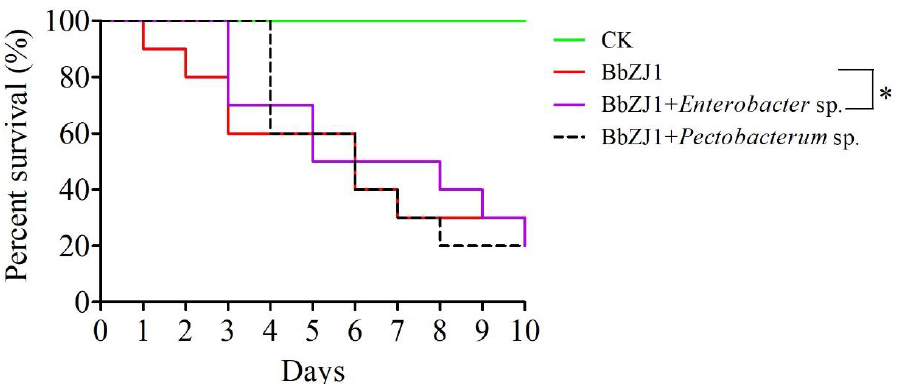
Figure 5. Effect of bacterial species on survival of Locusta migratoria co-inoculated with the bacterium and Beauvaria bassiana strain BbZJ1. The log-rank (Mantel–Cox) test method in GraphPad 5 software was used to analyze the differences among the survival curves. “*” Significantly different at 0.05